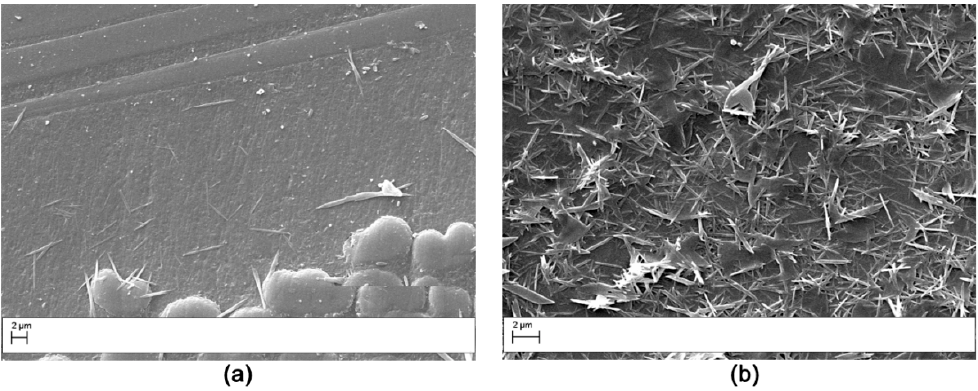
Figure 2. SEM morphology of the interlaminar region for the laminates modified with the soluble Virantage veils: ( a ) V1 (1000×); ( b ) V1 (2000×); ( c ) V2 (2000×).